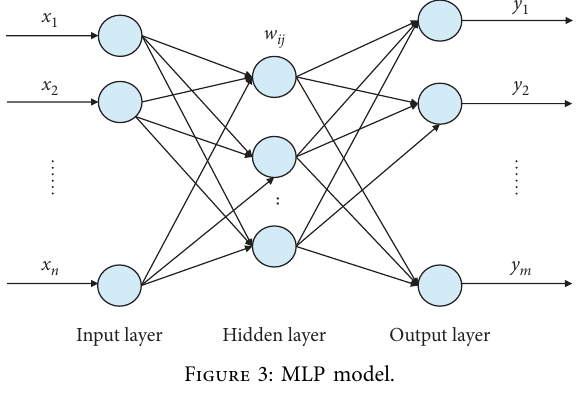
Figure 3: MLP model.